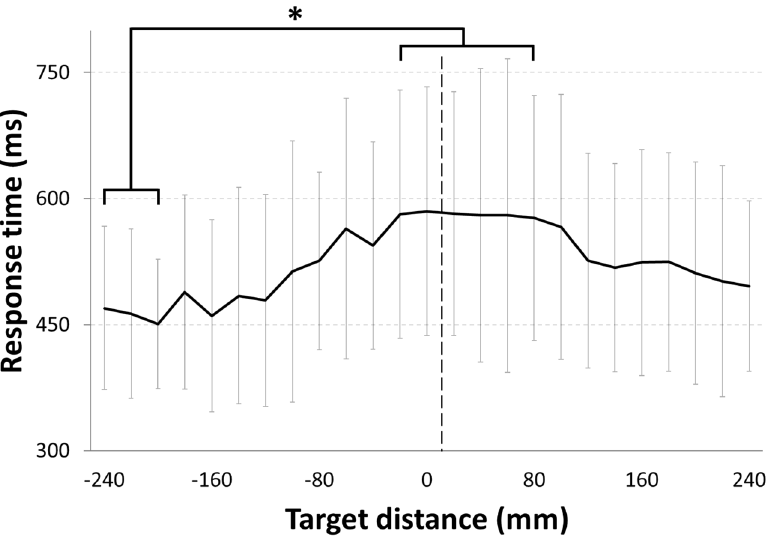
Figure 7. Response time for each target distance across participants; only main significant differences are represented. Target distance corresponding to the perceived boundary of reachability, averaged across participants, is represented by the vertical dotted